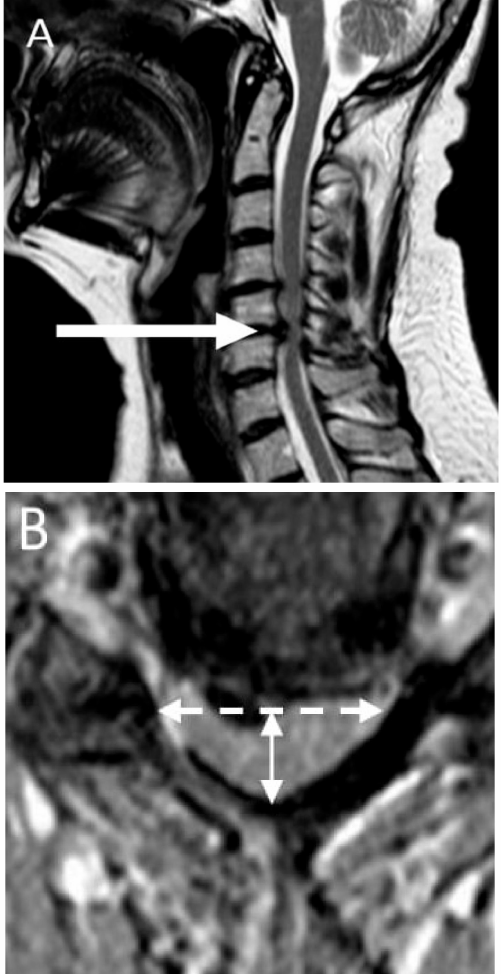
Figure 1. Patient with severe cervical spinal cord compression. ( A ) Sagittal T2-MRI sequence shows a level of maximal compression—C5/6 (arrow); ( B ) Compression ratio: anterior–posterior diameter (solid line double arrow) divided by the transverse diameter (dashed line double arrow) of the spinal cord on the axial T2 MRI image (taken at the level of maximum spinal cord compression; the result is 0.37 in this